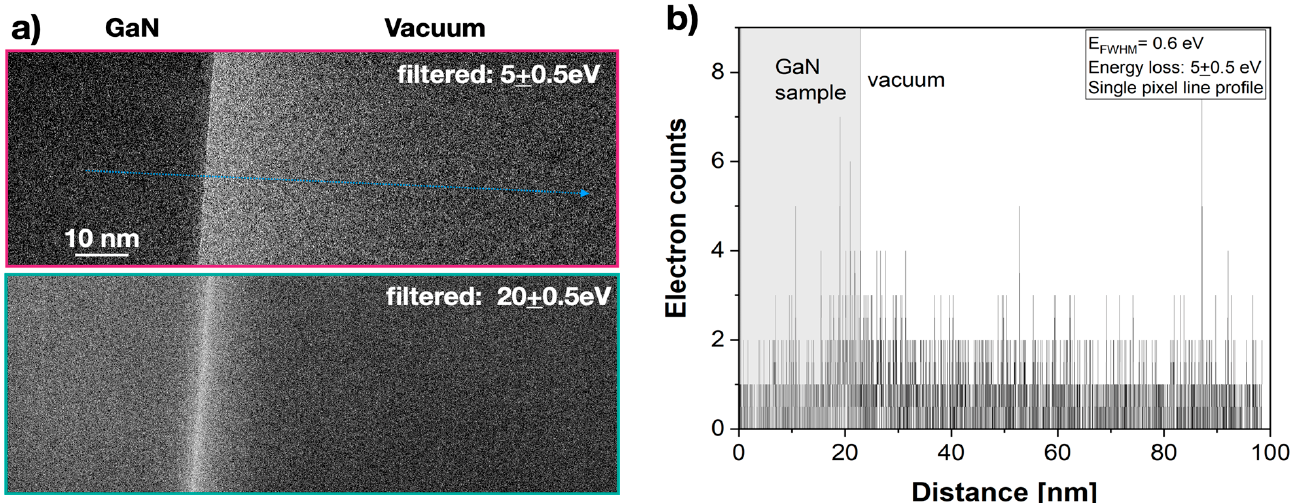
Figure 3. Amplitude image intensity from the sample/vacuum interface in the energy loss region. Fresnel oscillations were absent because ∆ f = 0. ( a ) Amplitude images with subtracted incident image intensity for 2 energy losses as indicated. Blue line: extraction of the line profile shown in ( b ). ( b ) Single-electron scattering events were detected with an outstanding S/N ratio. The resulting telegraph noise in the recorded EFTEM images was revealed by a line profile of single-pixel width. Averaging along the interface and the recording of image series were used for shot noise reduction.